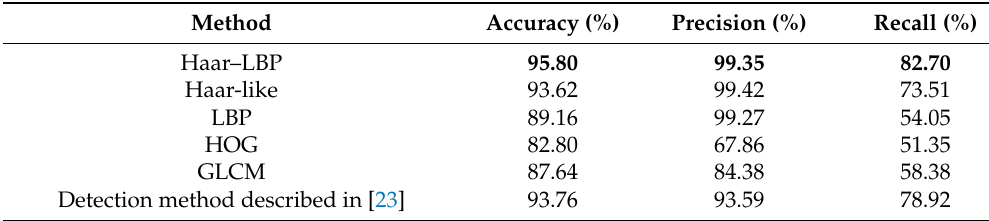
Figure 13. ( a ) The MWC image with initial target detection box. In (a), 1 denotes the detected region in the target box, 2 denotes the region with the target and 3 denotes the region without gas plumes. ( b ) The exact target region within the target box.